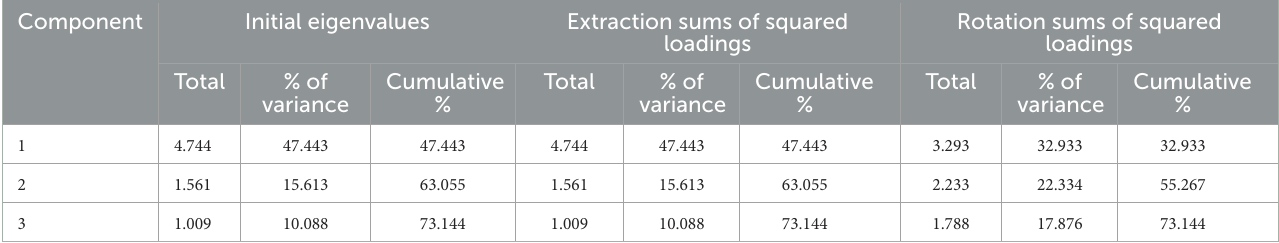
TABLE 10 Total variance explained (unwillingness to be an organ donor). Component